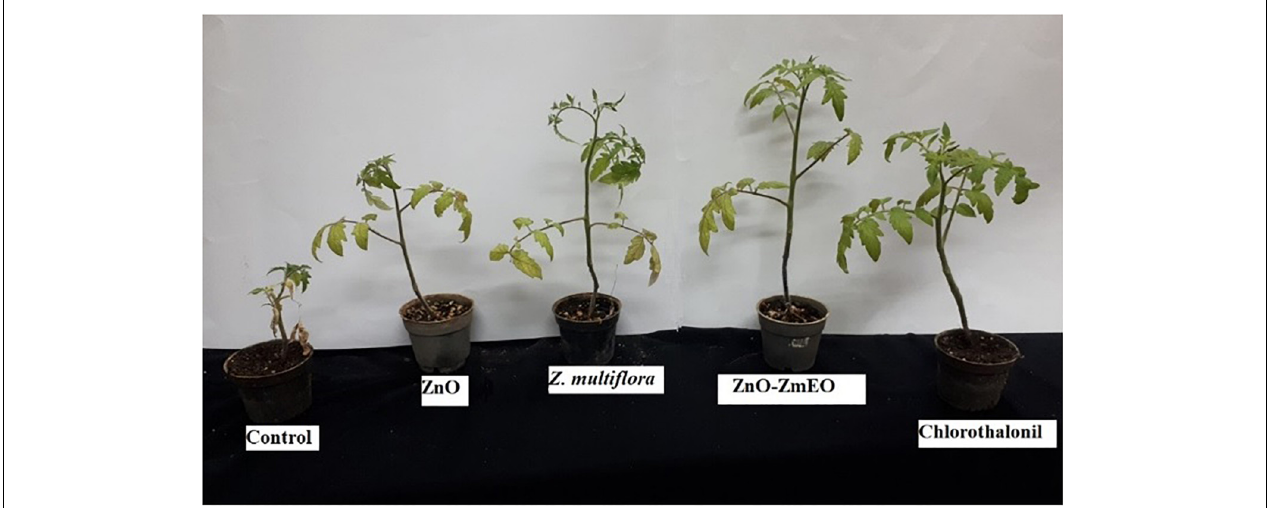
FIGURE 6 | In vivo antifungal activity of the ZnO, pure Z. multiflora EO, ZnO-ZmEO, and chlorothalonil against Alternaria solani on tomato plants.